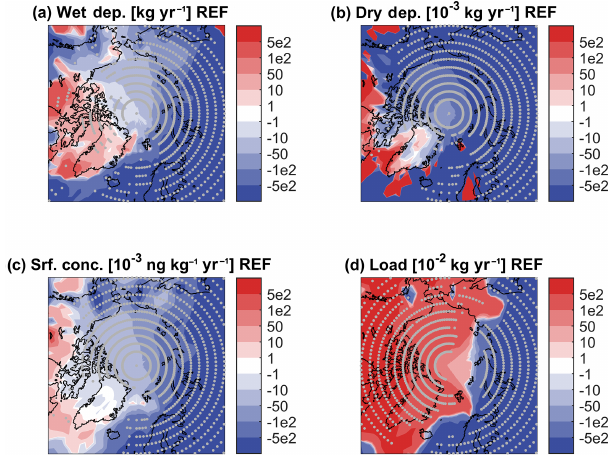
Figure 3. Winter (DJF) trends (1980–2005) of BC wet deposi- tion (a) , dry deposition (b) , surface concentration (c) and total load (d) for the ECHAM5–HAMMOZ FIX2000 simulation. Grey dots represent the grid points with trend significant at 5%